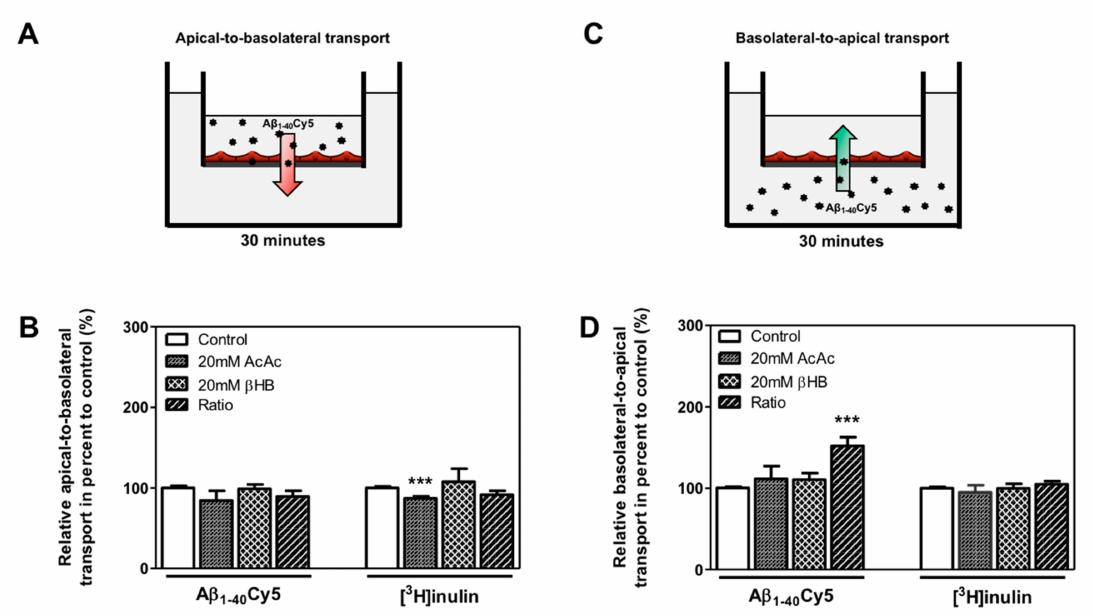
Figure 4. Effect of KBs on A β transport across BBB. ( A ) Schematic representation of the human in vitro BBB model used for ( A ) apical-to-basolateral (red arrow) and ( C ) basolateral-to-apical (green arrow) A β transport. After 48 h of treatment with KBs, A β 1–40 Cy5 or [ 3 H]inulin was added to the ( B ) apical compartment or ( D ) basolateral compartment, incubated for 30 min, and permeability was then assessed. The data represent the mean ± SEM obtained from at least three independent experiments relative to the control conditions, each of which was performed in triplicate (*** p <